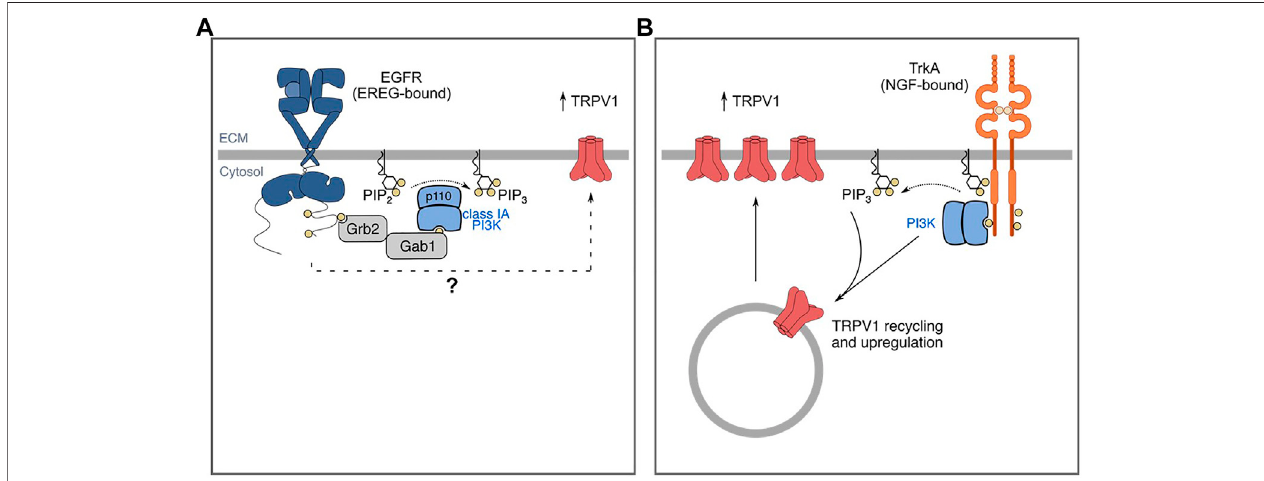
FIGURE 3 | EGF/EREG-EGFR and NGF-TrkA signaling mechanisms that contribute to pain/sensitization. (A) EREG-mediated sensitivity to formalin and capsaicin involves TRPV1. (B) Similarly, NGF mediates sensitivity to capsaicin and formalin. NGF-TrkA signalling mediates traf fi c of TRPV1 to the plasma membrane through a PI3K-dependent mechanism. The mechanisms by which NGF mediates sensitivity through these signaling intermediates is more well-characterized and thus, the mechanismsbywhichEREG-EGFRsignalingpromotessensitivitywarrantsfurtherinvestigation. ThemechanismsbywhichotherEGFRligandsmediatesensitivity are incompletely understood. Additionally, whether and how EREG-EGFR and EGF-EGFR signaling may promote sensitivity to distinct stimuli in various animal models remain to be